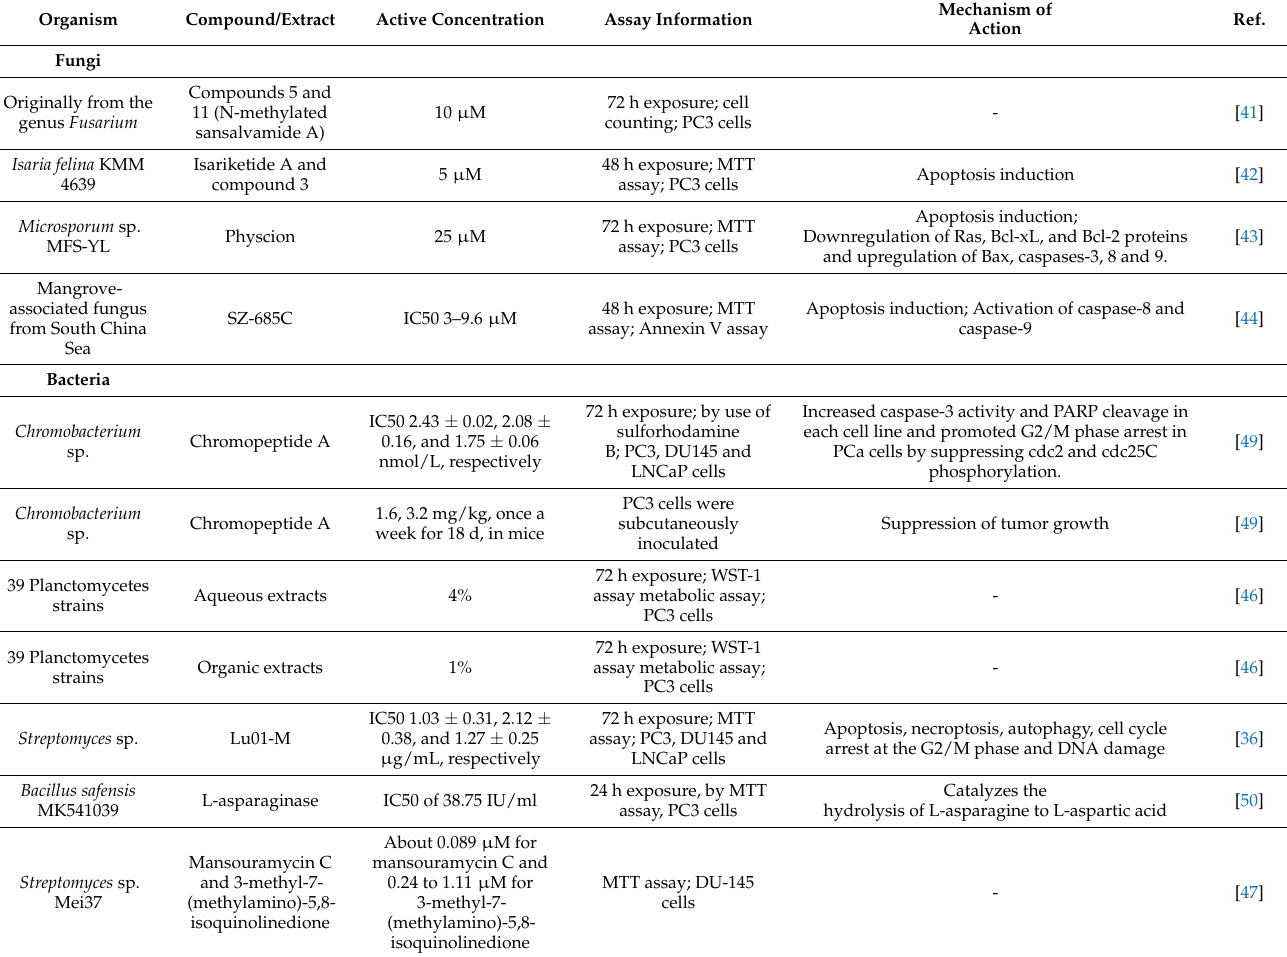
Table 2. Compounds/extracts from marine microorganisms with activities against prostate cancer. Abbreviations: MTT for 3-(4,5-dimethylthiazol-2-yl)-2,5-diphenyltetrazolium bromide, WST-1